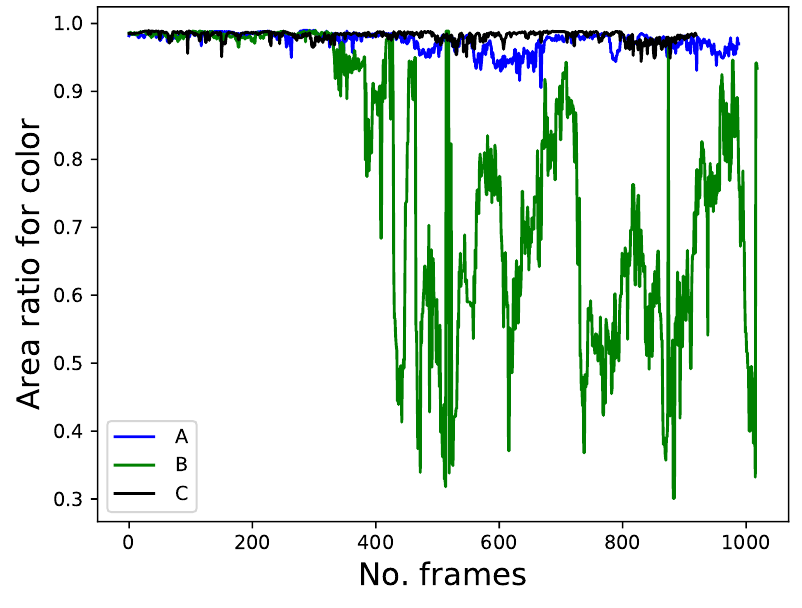
Figure 13. Color feature. The goal of normalization is to change the values of the height difference, localization differences, and color features to a common scale without distorting the differences in the ranges of values. Figure 14 shows the normalization features of people. The blue, green, and black curves represent person A as the target person and persons B and C as non-target persons, respectively, when they all wore blue t-shirts. The robot started detecting another person as the first non-target person at frame number 466 until frame number 610, while the target person completely occluded the second person during walking. The second person was detected as a non-target person at frame number 666 until 759 after the